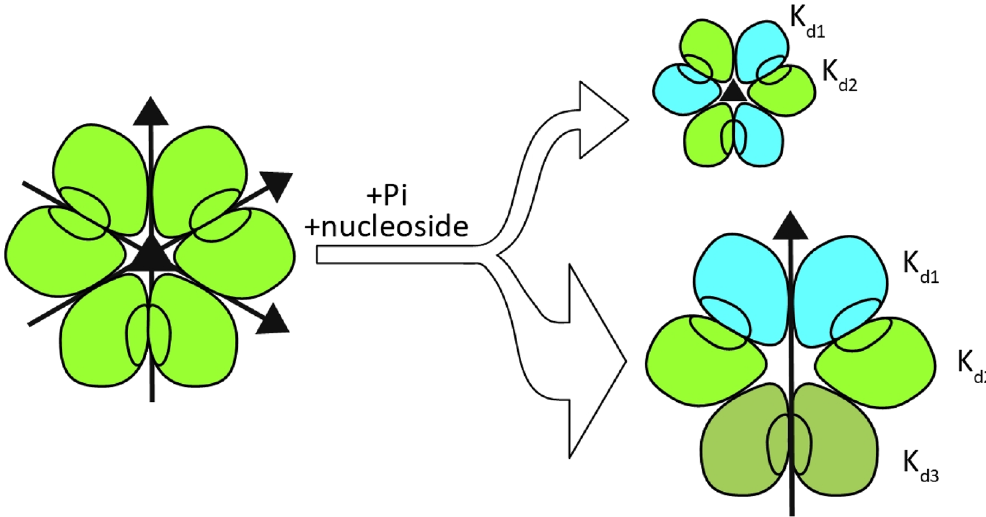
Figure 7. The schematic view of the E. coli PNP hexameric molecule, in the apo form, with the three-fold and the two-fold symmetry axes (left, based on PDB 1ECP 8 ), and in the complexes with ligands, phosphate and nucleoside (right). In just one ternary complex of the E. coli PNP with its ligands (PDB 1K9S) 9 the three-fold symmetry is retained (upper right), and all three dimers are with one monomer in the open (blue) and one in the closed (green) conformation of the active sites. The binary enzyme-phosphate complex, and the majority of various ternary enzyme-phosphate-nucleoside complexes show only two-fold symmetry (lower right, see also Fig. 1), as one of three dimers is symmetric (rotten green), hence different than two other unsymmetrical dimers (blue-green). The present study shows that this is more likely not a crystallographic artefact as also in solution the three-binding-site model is necessary to properly describe interaction of this enzyme with ligands, hence dimers are probably also functionally not